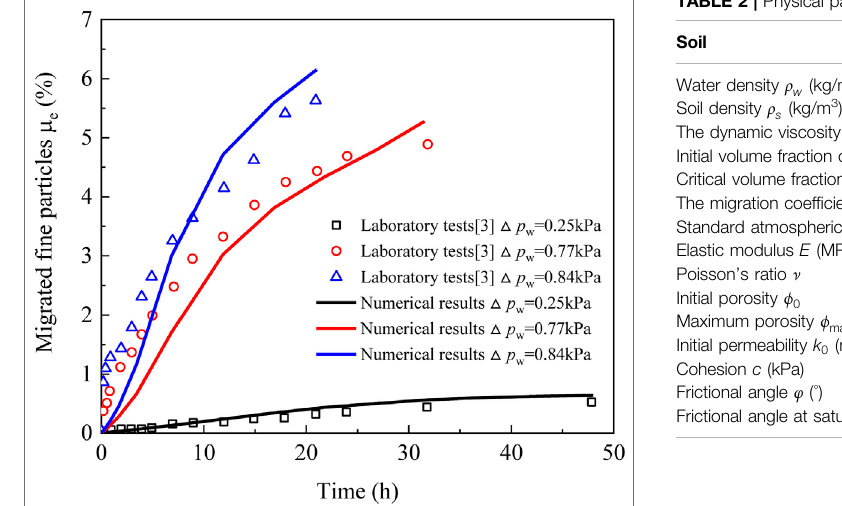
TABLE 2 | Physical parameters for soils (Deng, 2006; Ding et al., 2020).